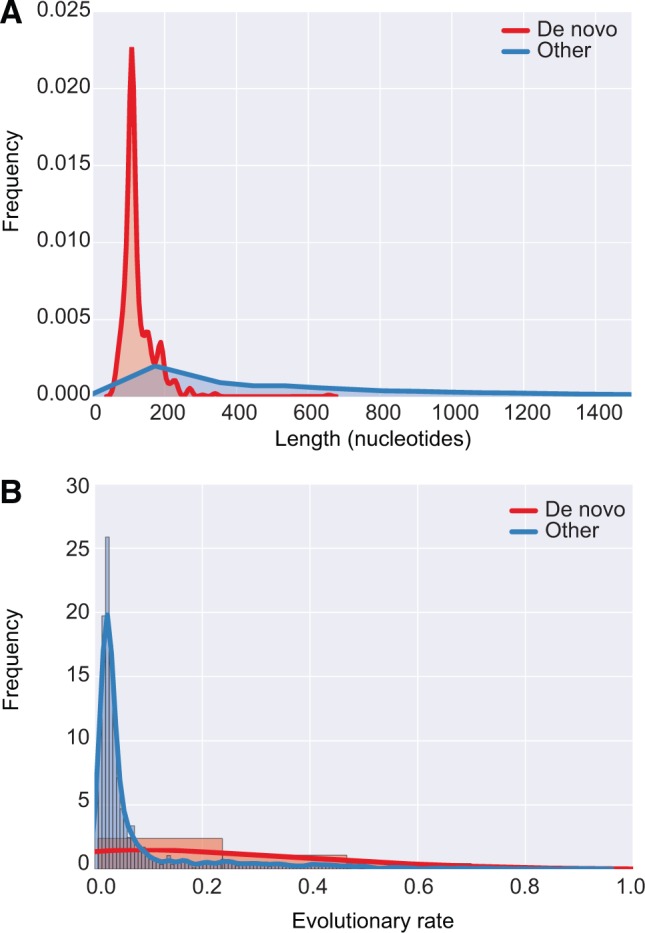
Recently-evolved, de novo genes are shorter than older genes in Spraguea, and experience more variable selective pressures. (A) Genes that have emerged since the divergence of the Celtic Sea and North American populations are significantly shorter than older genes (P = 1.2 × 10−298, Wilcoxon rank-sum test), consistent with their recent emergence from noncoding sequence. (B) Distribution of within-gene family evolutionary rates [calculated as mean pairwise Kimura 2-parameter genetic distances (Kimura 1980)] for de novo versus older gene families. Although the means of these distributions are similar (0.19 for de novo, 0.09 for older, P = 0.13, Wilcoxon rank-sum test), the variance of the rates for de novo genes is significantly greater (0.12 for de novo genes, 0.02 for older, P = 0.0005, Levene’s test). These results suggest that, while some de novo genes experience significant selective constraint (fig. 3), others are likely non-functional and subject to rapid turnover through evolutionary time.